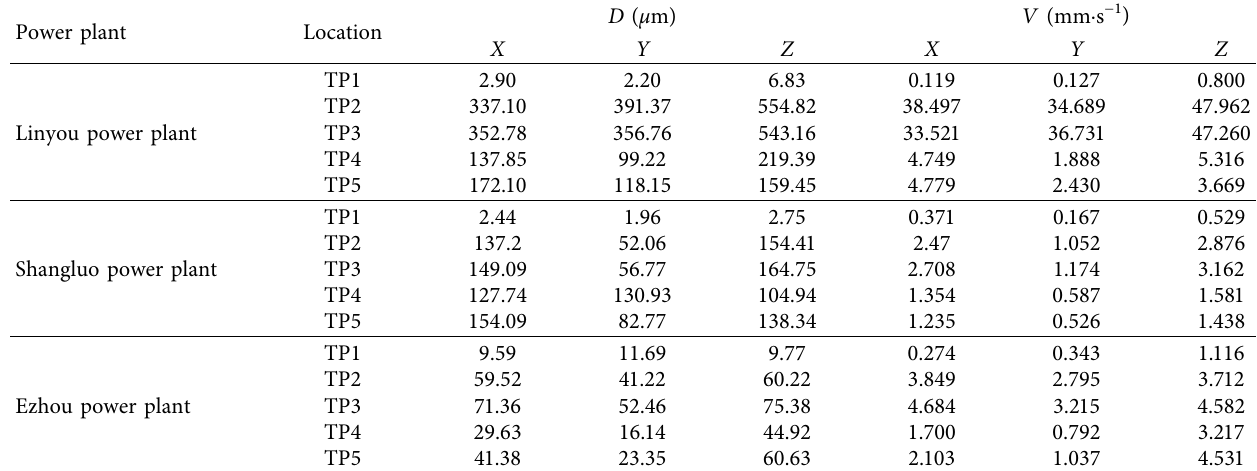
Table 3: Maximum displacements and velocities found in vibration